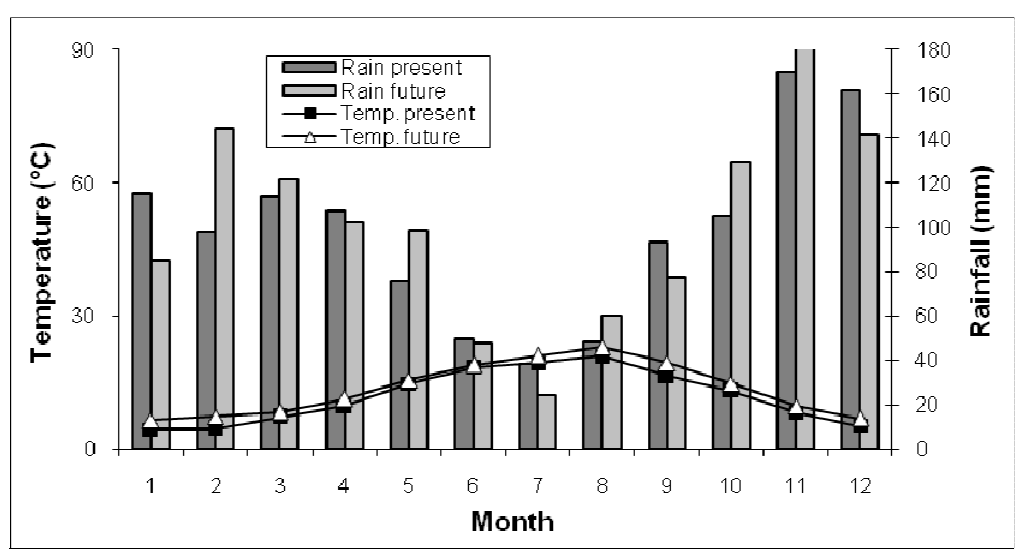
Figure 3. Thermo-pluviometric diagram descriptive of the present and future climate scenarios for the areas covered by deciduous oaks forests (FT 8), which are the most widespread forest type over the Italian